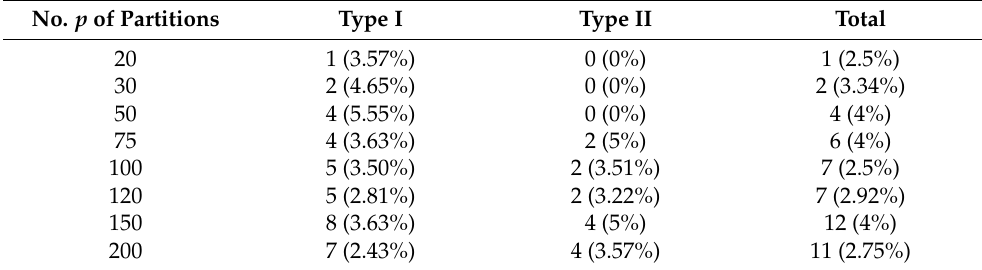
Table 6. Z24 Bridge: effect of the number p of partitions on the occurrence and percentage of Type I, Type II, and total errors in detecting damage.